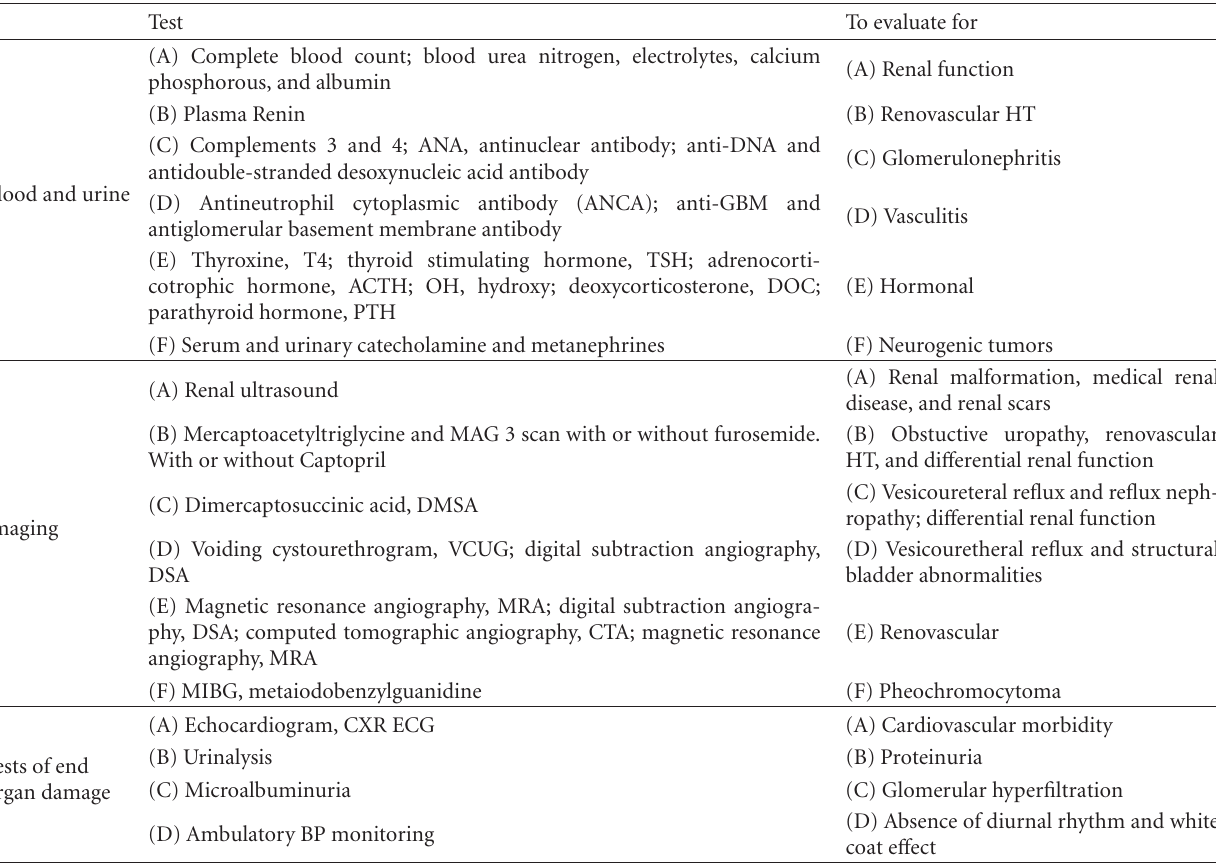
Table 4: Suggested work-up for stages 1 and 2